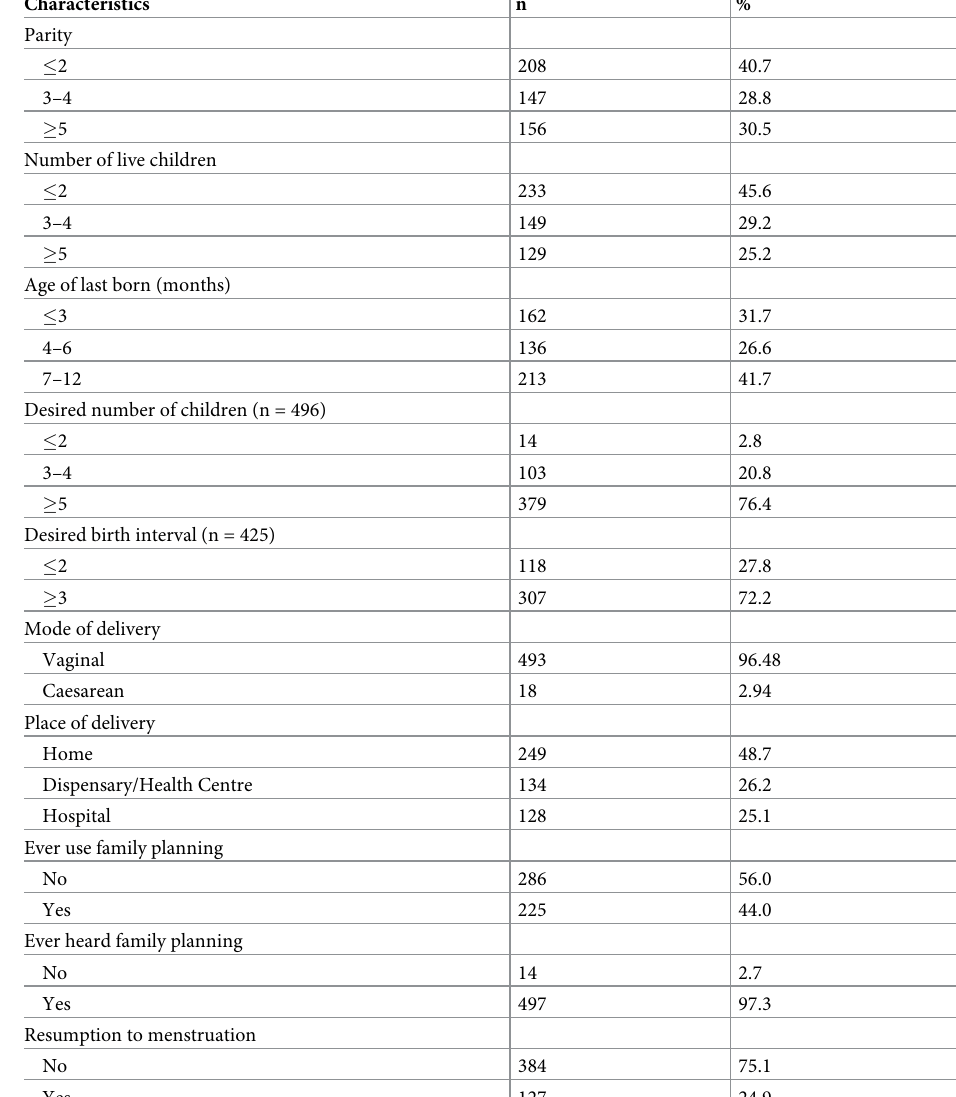
Table 2. Reproductive health related characteristics of study participants (N = 511).